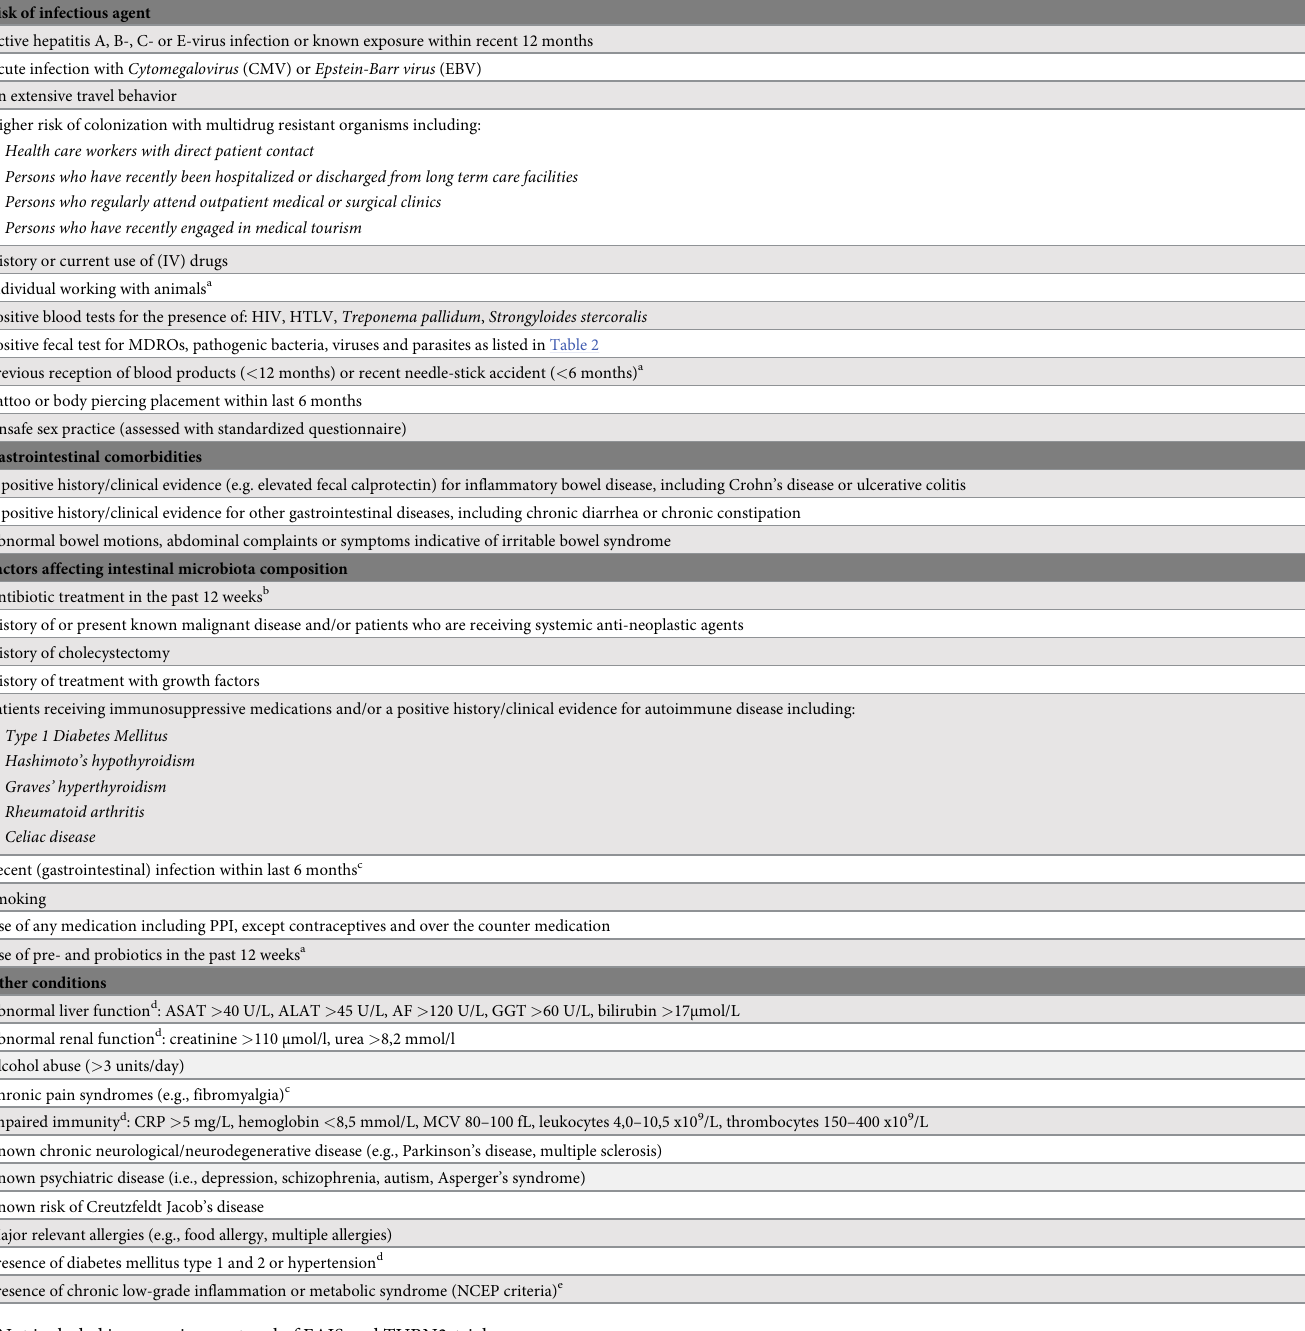
Table 1. Exclusion criteria donor recruitment. Risk of infectious